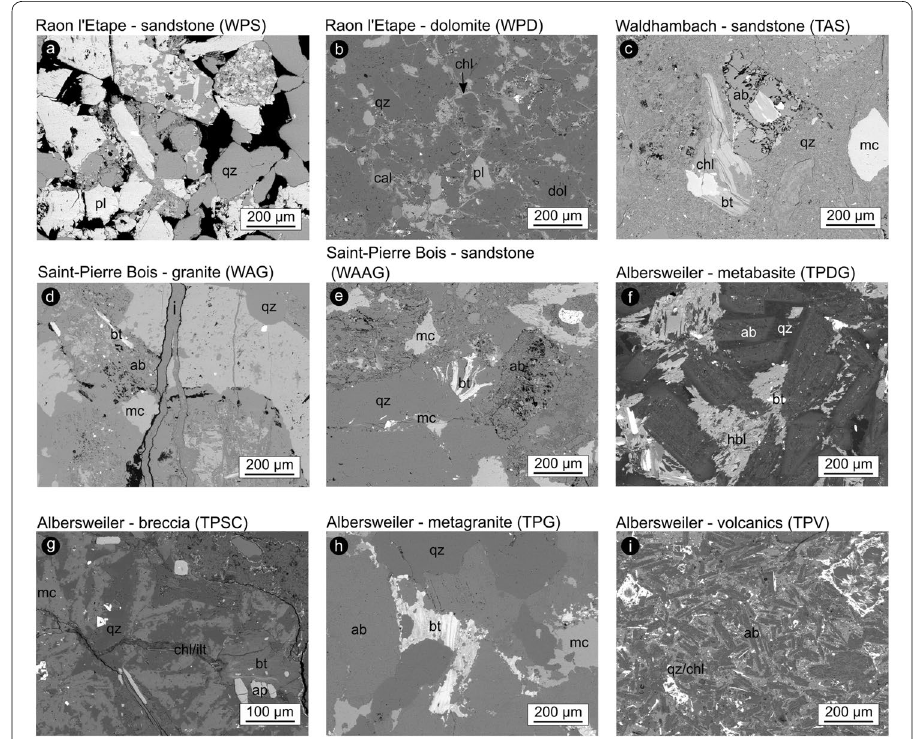
Fig. 5 Backscatter electron microscope images of select rocks characterised in this study. Black space is porosity. a Sandstone (WPS) from Raon l’Etape. b Dolomite (WPD) from Raon l’Etape. c Sandstone (TAS) from Waldhambach. d Granite (WAG) from Saint Pierre Bois. e Sandstone (WAAG) from Saint Pierre Bois. f Metabasite (TPDG) from Albersweiler. g Breccia (TPSC) from Albersweiler. h Metagranite (TPG) from Albersweiler. i Hydrothermally altered Permian volcanics (TPV) from Albersweiler. pl plagioclase, qz quartz,